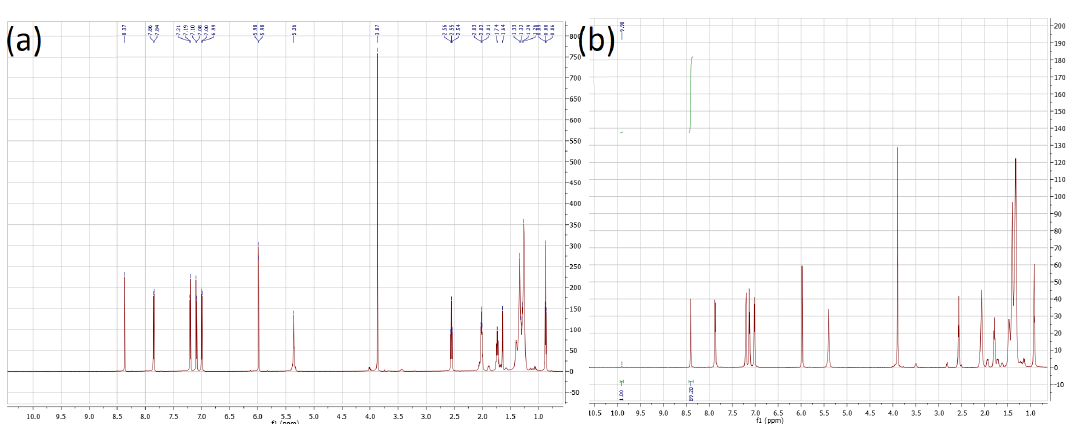
Figure 3. Optical photomicrographs under polarized optical microscopy (POM) of the compound I during the cooling scan. ( a ) Crystal phase at 20 °C and ( b ) SmA phase at 37.0 °C. Table 1. Phase transition temperatures (°C), enthalpy of transition ΔH (kJ/mol), and normalized entropy of transition, ΔS /R for compound I upon heating/cooling cycles. Heating Process